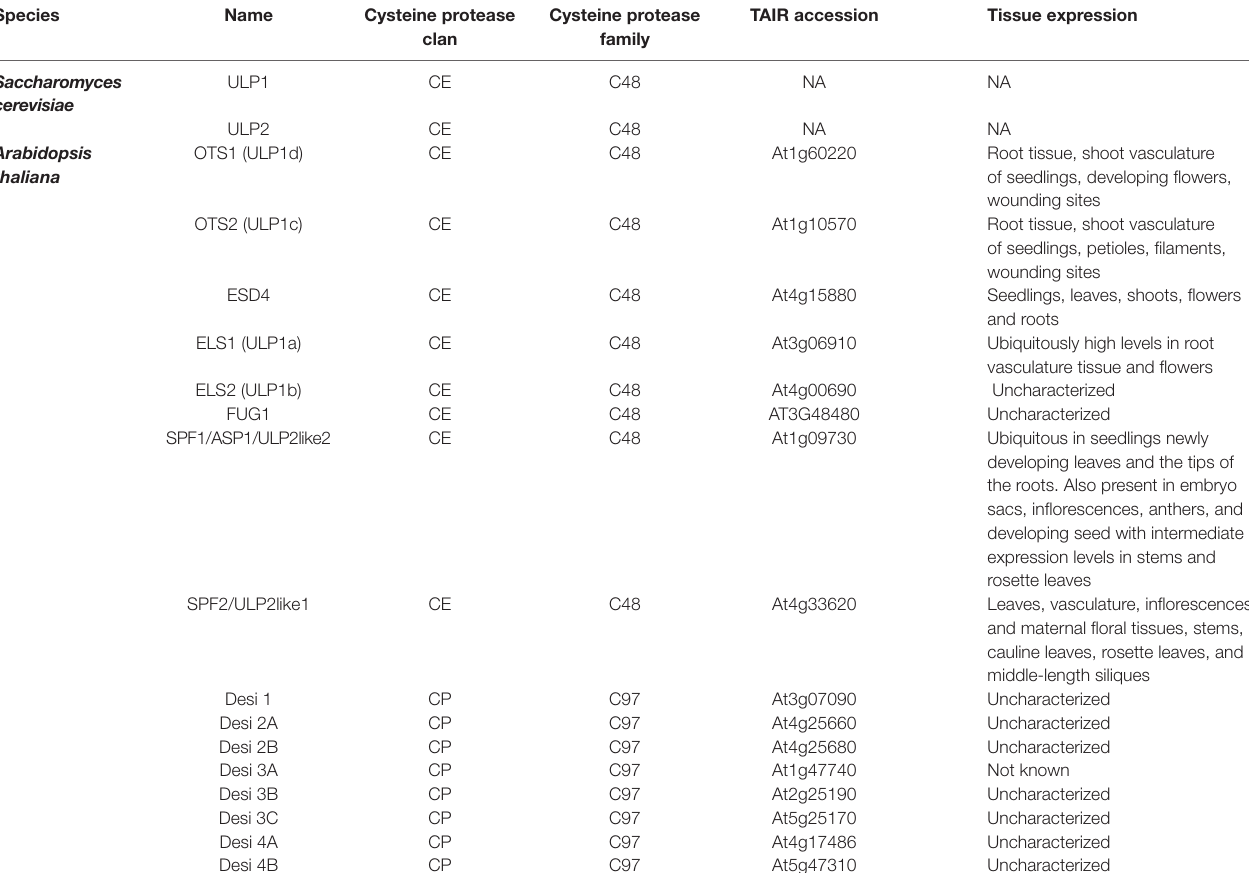
TABLE 1 | List of currently identified SUMO proteases in yeast and Arabidopsis , giving all their known names, TAIR accession number, cysteine protease classification, and tissue expression.